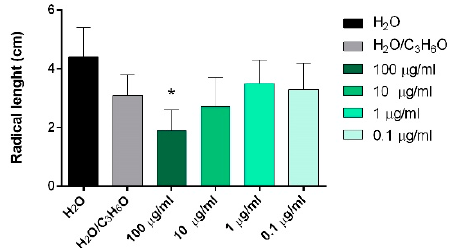
Figure 3. Phytotoxic activity of C. sempervirens ( A ) and Z. officinale ( B ) EOs against radical elongation of Lepidium sativum L., 120 h after sowing. Results are the mean ± standard deviation ( n = 3) of three independent experiments. * p < 0.05, ** p < 0.01 compared to control (ANOVA followed by Dunnett’s multiple comparison test).